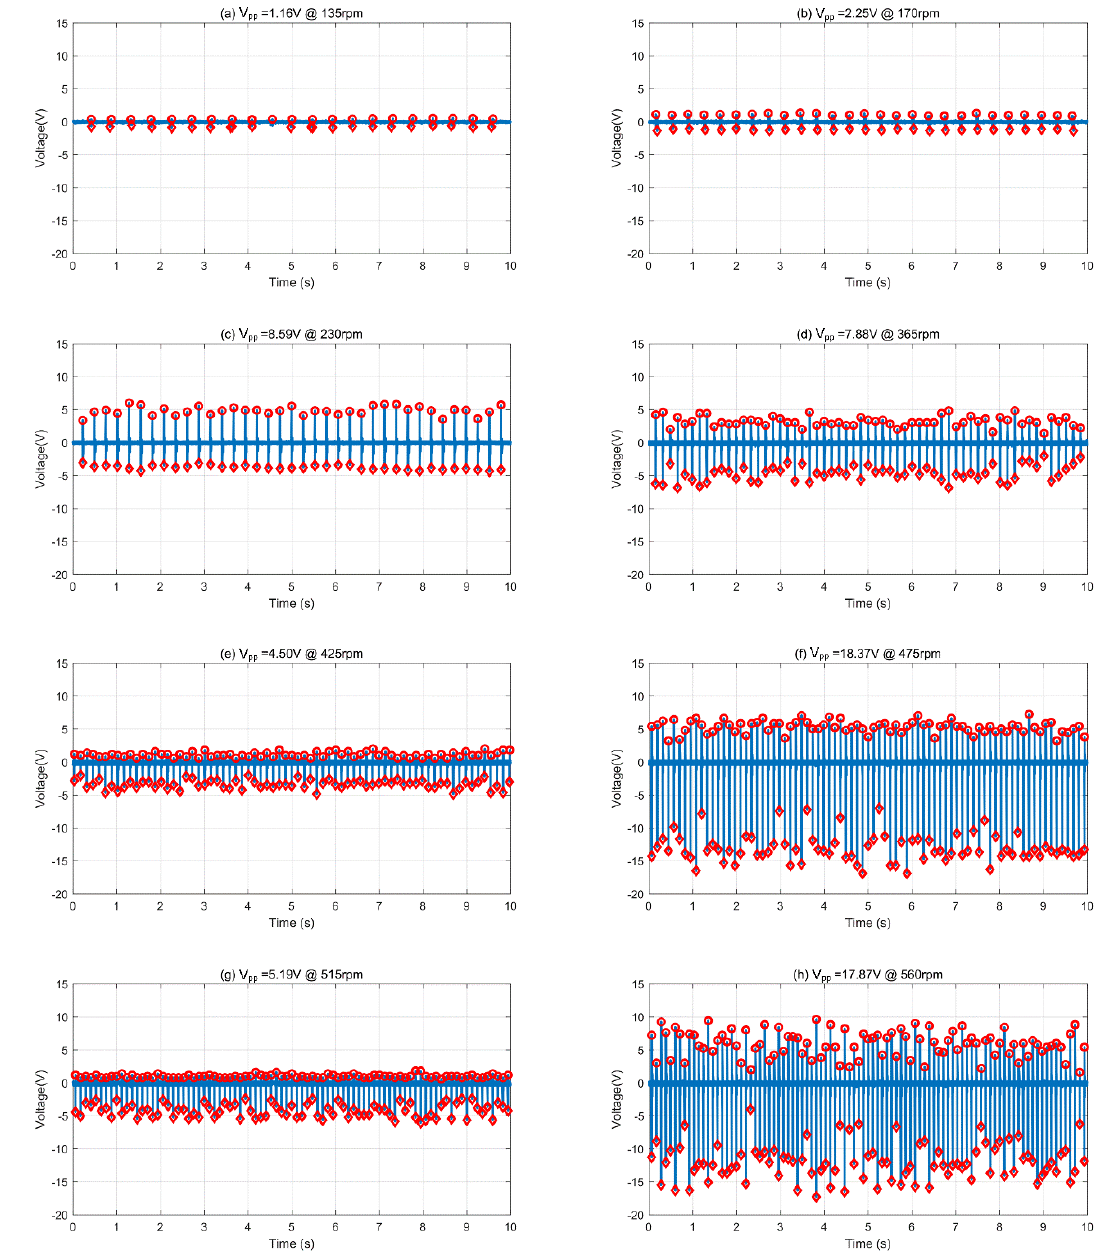
Figure 6. Measured voltage–time curves at different rotation